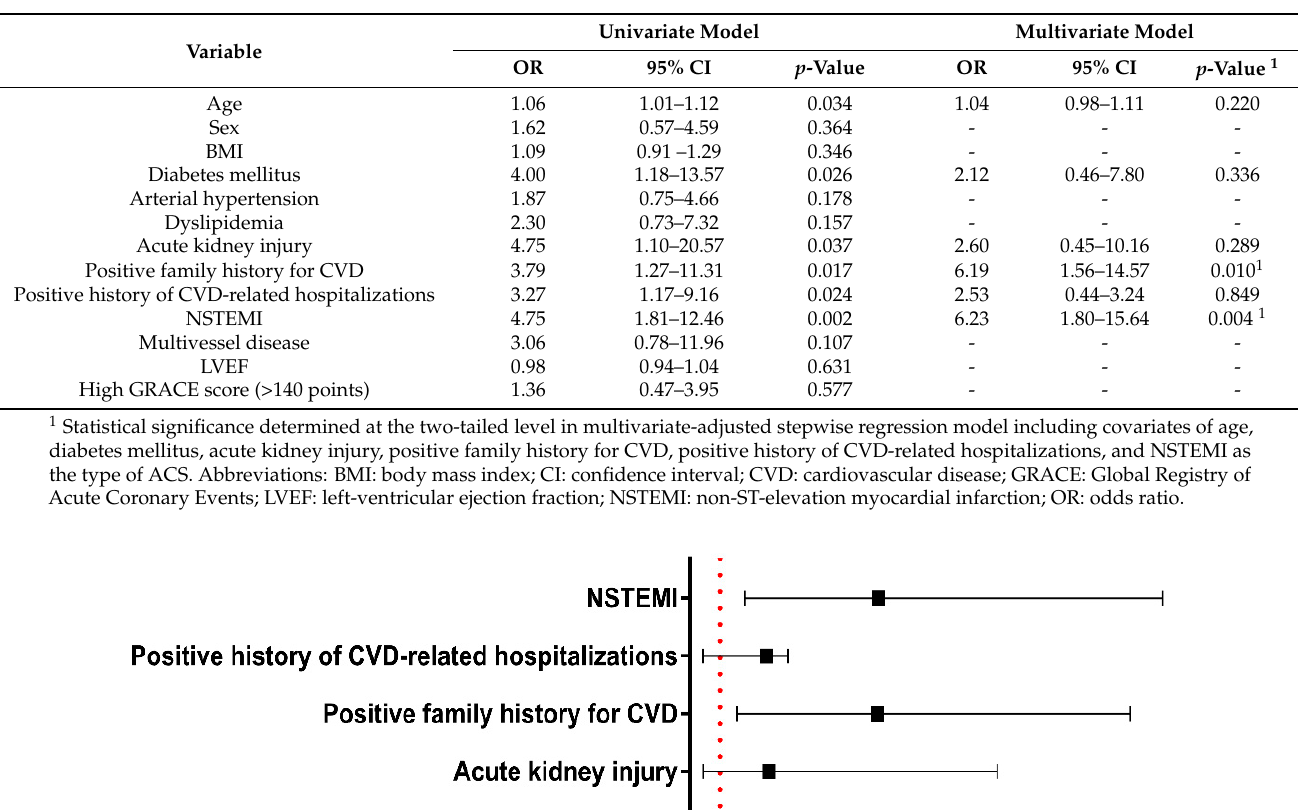
Table 3. Predictors of highest tertile of plasma dp-ucMGP levels in the total ACS patient cohort ( n = 90), derived from binary logistic regression analysis.